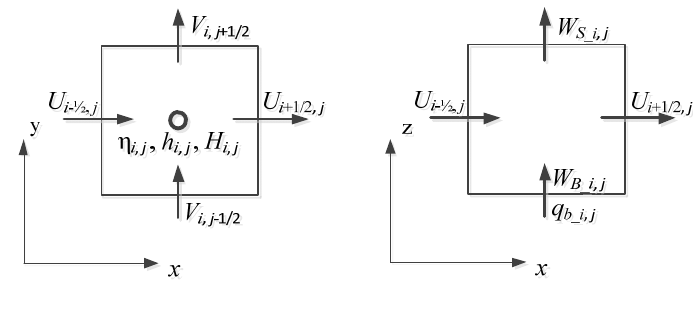
Figure 1. Layout of variables.